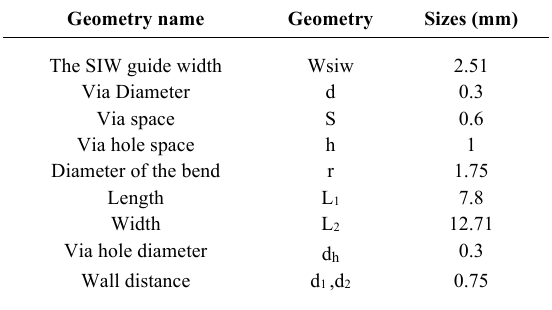
FIGURE2. The Two-way SIW power divider structure in 3D. Figure 2 represents the optimized two-way SIW power divider in 3D form. TABLE I. Parameters of the waveguide power